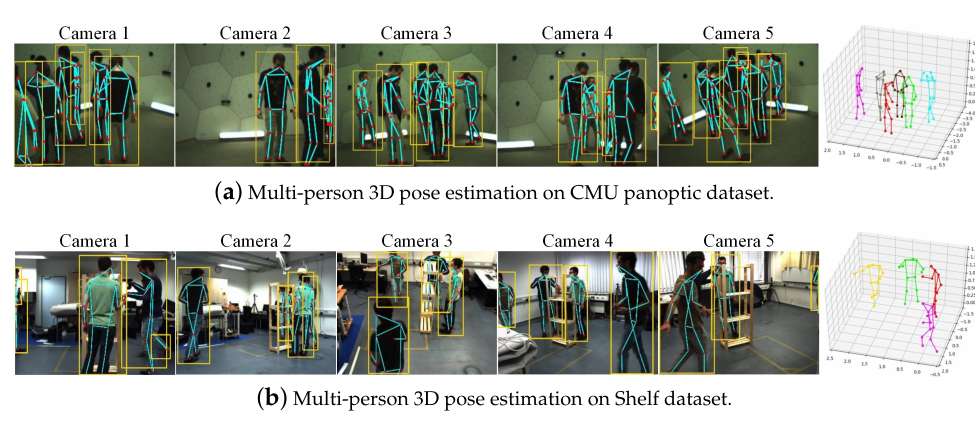
Figure 7. Qualitative results from three different single-person datasets. We show the 2D pose on the original image and the 3D pose from Reference [57].